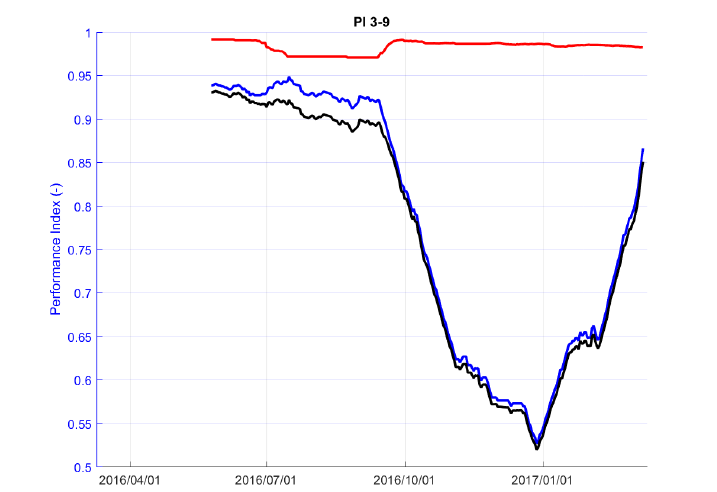
Figure 12. Performance parameters variations over time: P 1 (blue line), P 2 (red line) and Performance Index, PI (black line), Roncovetro—cluster 1, node couple: